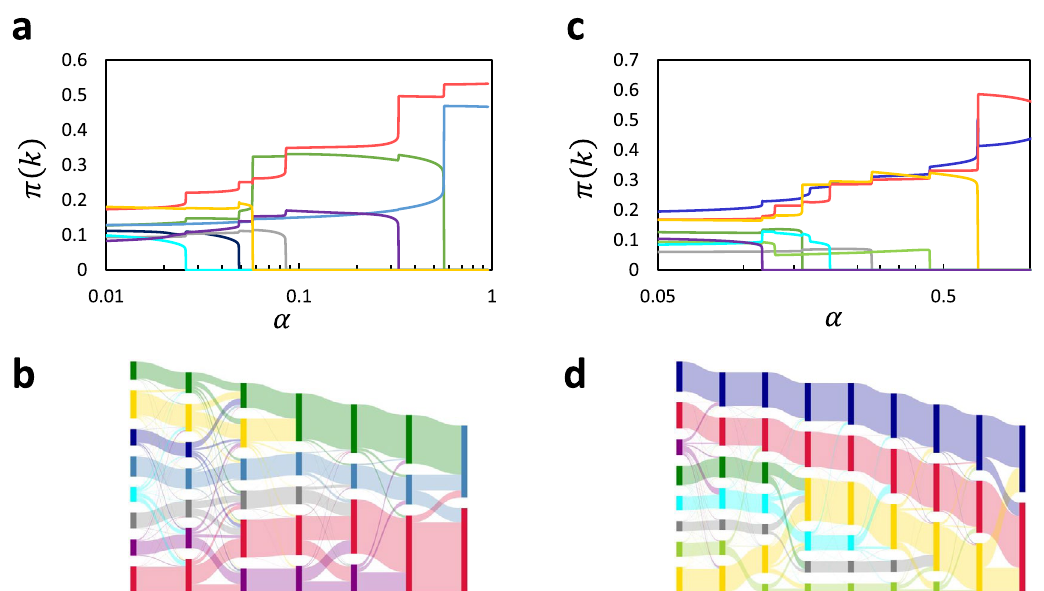
Figure 5. Hierarchical organization of pervasive communities of the karate club network ( a , b ) and the mouse whole brain network ( c , d ). ( a , c ), Each layer of hierarchy emerges through a series of discrete phase transitions induced by quasi-static increase in α . ( b , d ) Sankey diagrams illustrating parent–child relationships in hierarchical organization of pervasive communities. Vertically aligned rectangles represent communities in each layer, and the width of a band connecting a child community (one rectangle in one layer) and one of its parent communities (one rectangle in the next layer) expresses the amount of flow of the probability from the former to the